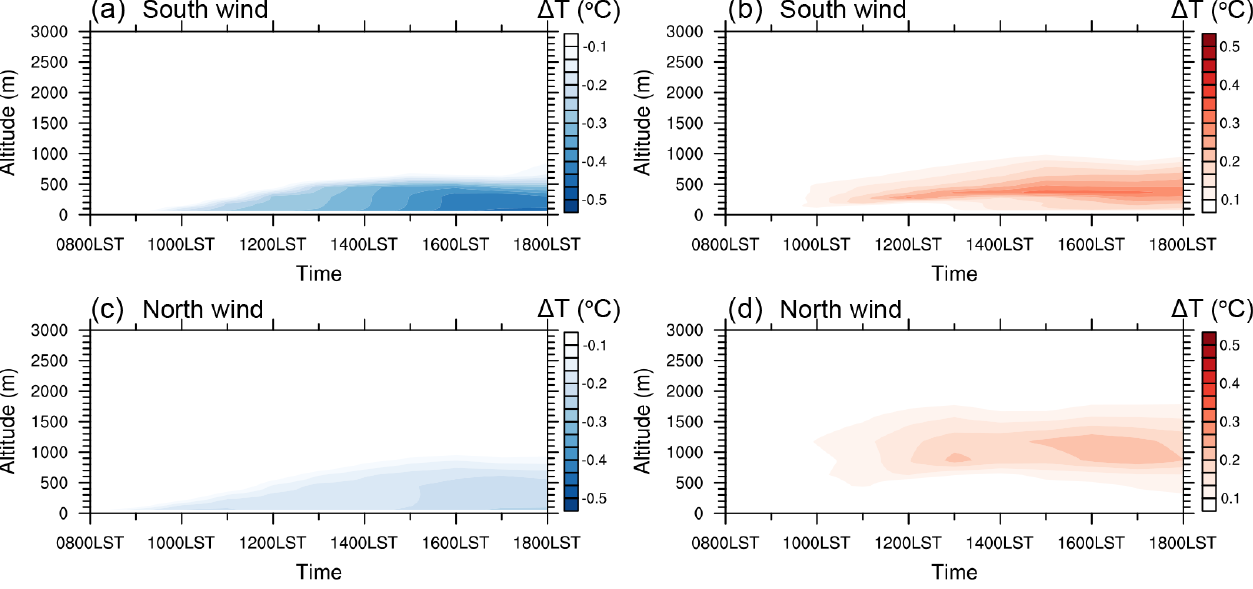
Figure 13. Temporal evolution of the temperature profile variation influenced by aerosol radiative effect (ARE). (a) ARE by other aerosols (EXP_WFexBC – EXP_WoF) and (b) ARE by BC (EXP_Ctrl – EXP_WFexBC) under the prevailing southerly wind. (c) ARE by other aerosols and (d) ARE by BC under the prevailing northerly